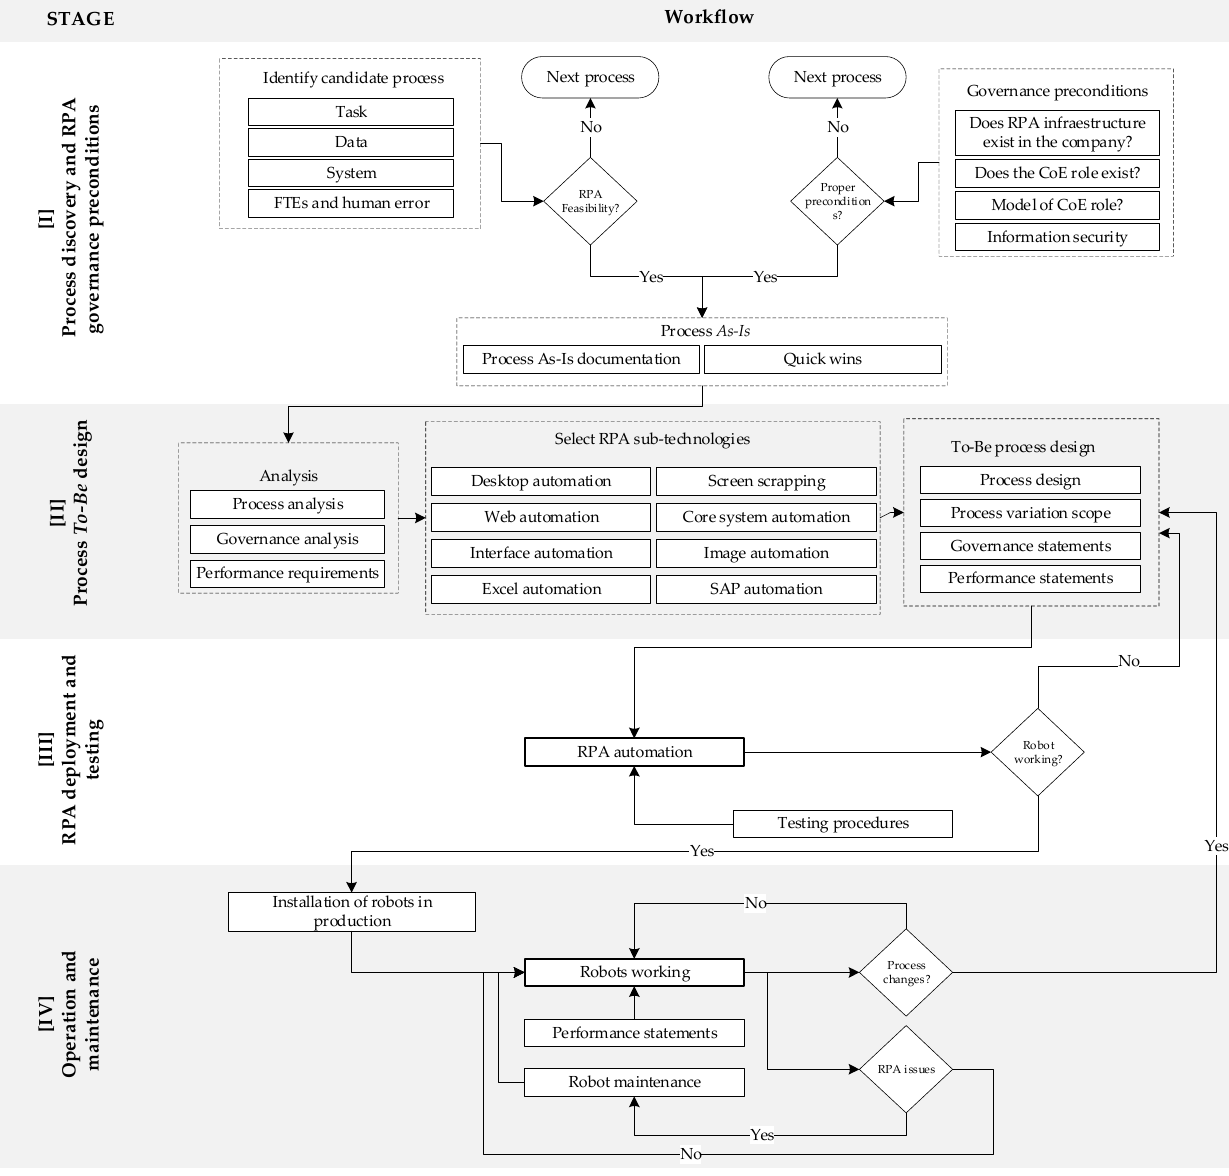
Figure 5. Proposed workflow for the automatization SHM process.